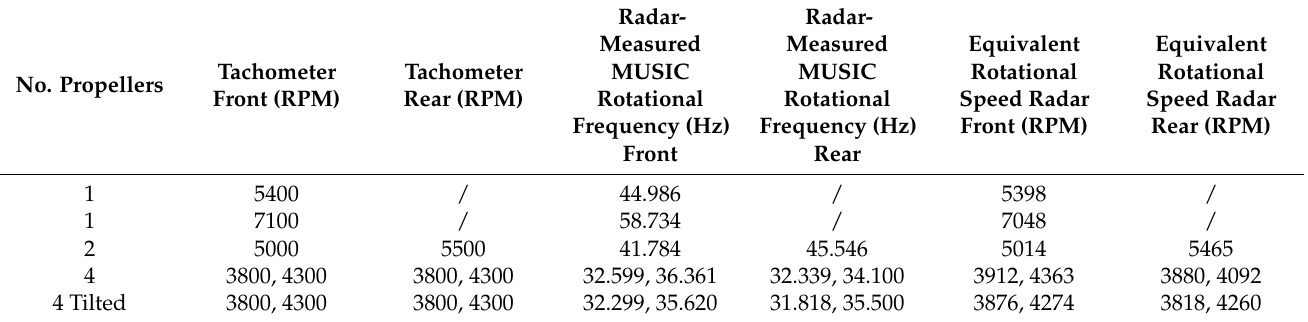
Table 3. Results obtained from the laser tachometer and the MUSIC